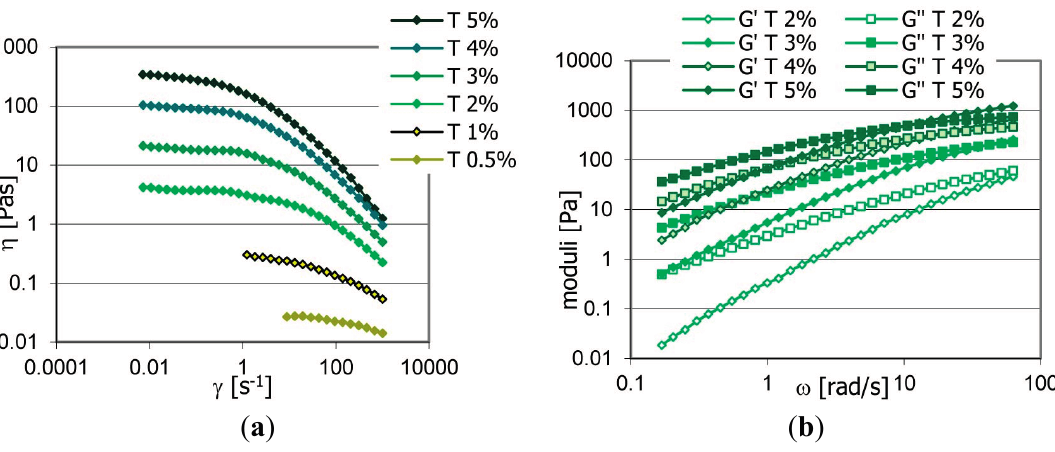
Figure 1. ( a ) Viscosity trends vs . shear rate; ( b ) G’ and G’’ trends as a function of the frequency of tamarind seed polysaccharide (T) samples at different